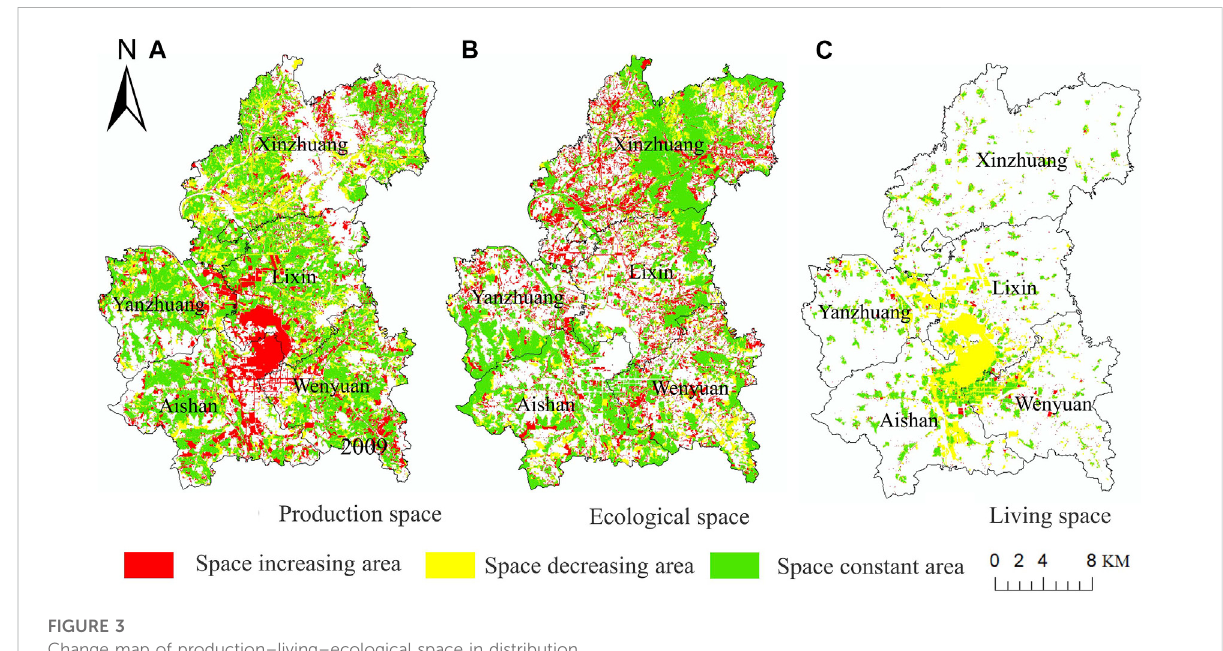
FIGURE 3 Change map of production – living – ecological space in